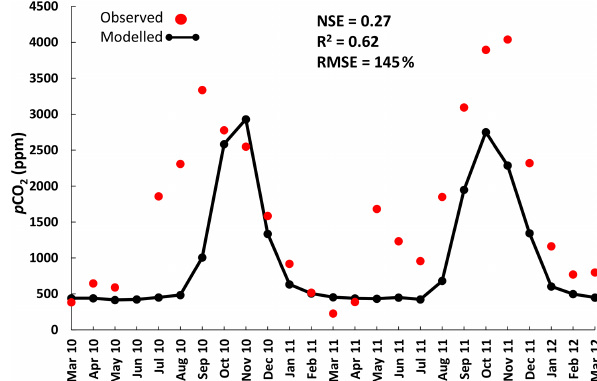
Figure 5. Observed (Borges et al., 2015a) versus simulated DOC concentrations at several sites along the Congo and Oubangui rivers. See Fig. 1 for locations. The simulated and observed DOC concen- trations represent the median values across the particular sampling period at each location detailed in Borges et al. (2015a).